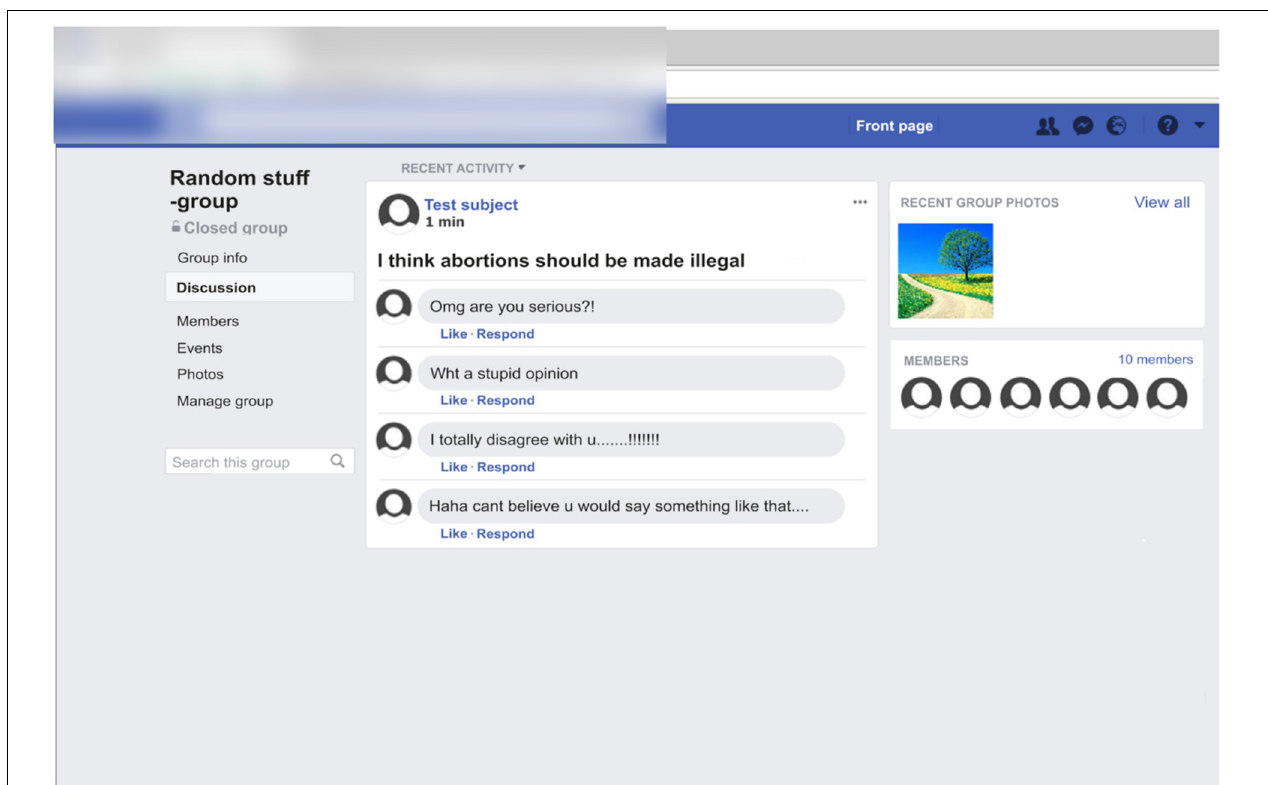
FIGURE 1 | An example screenshot (translated from Finnish to English for descriptive purposes) of the mock Facebook environment used in the study. The response of the participants to a controversial statement is presented as a “post” in a generic Facebook group. The post is followed by four comments from perceived peers. In this example, the participant has responded with “agree” to a controversial statement and has received negative peer feedback to their “post” from peers.